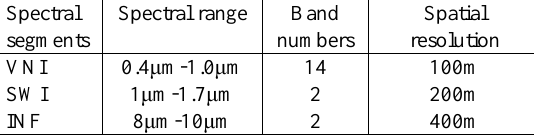
Table 1. Part of the parameters of